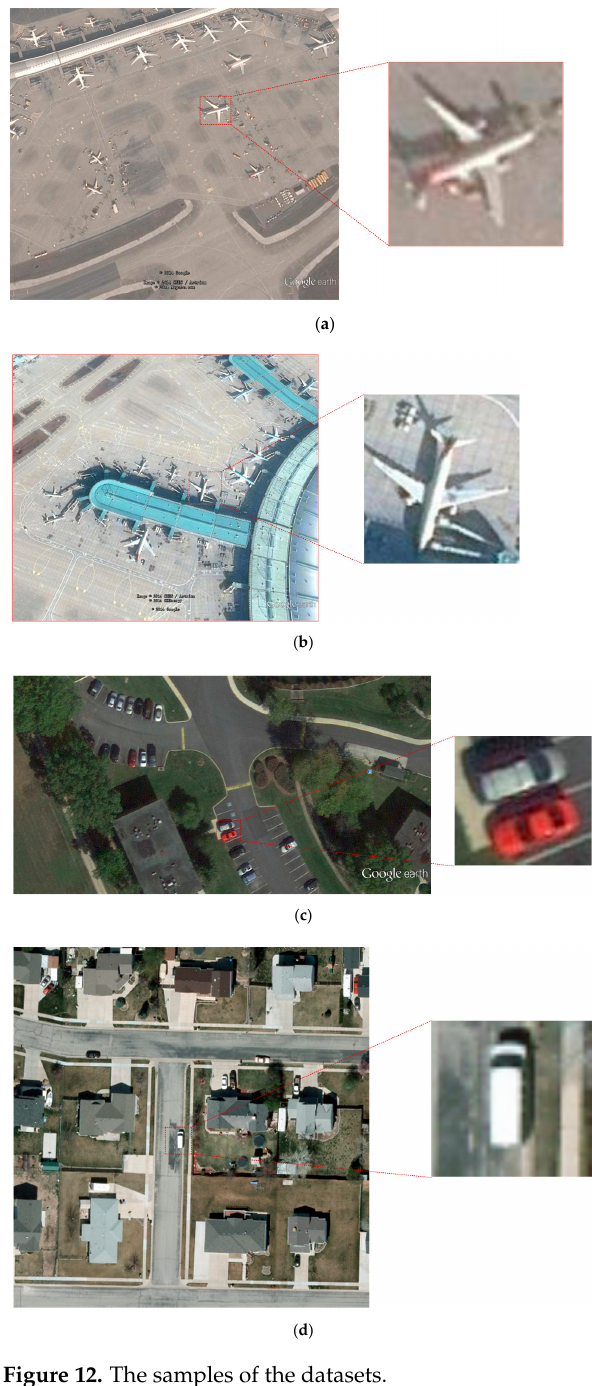
Figure 12. The samples of the datasets.